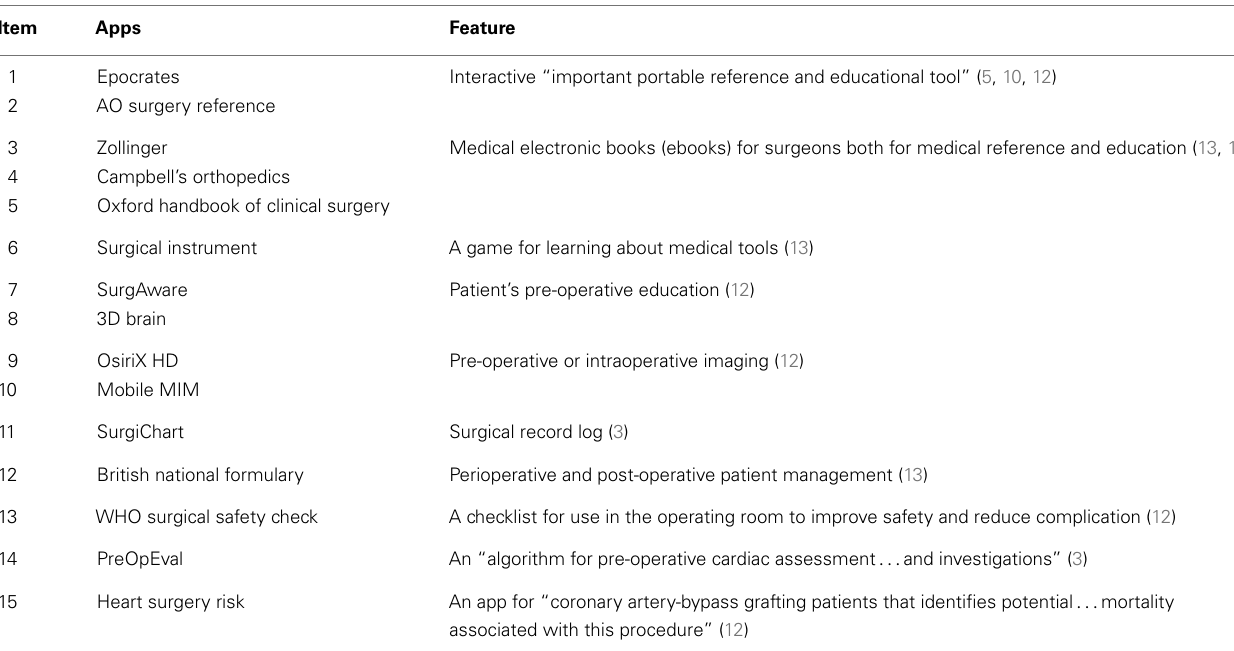
Table 1 | Mobile application in surgery